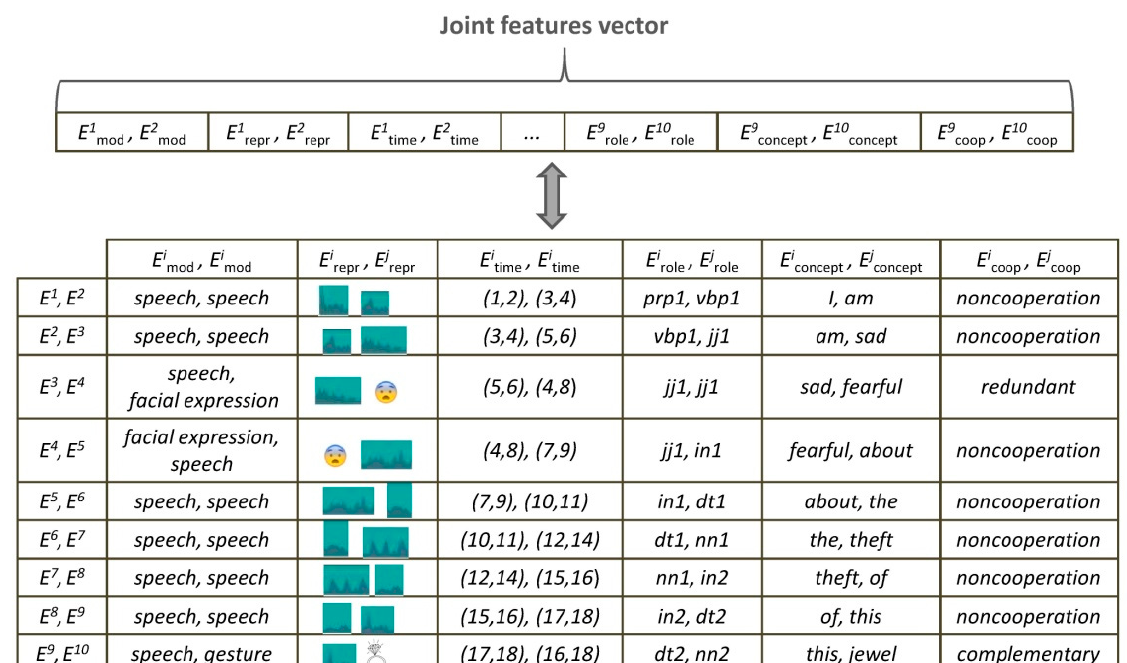
Figure 4. Example showing the pairs of elements of the joint features vector.